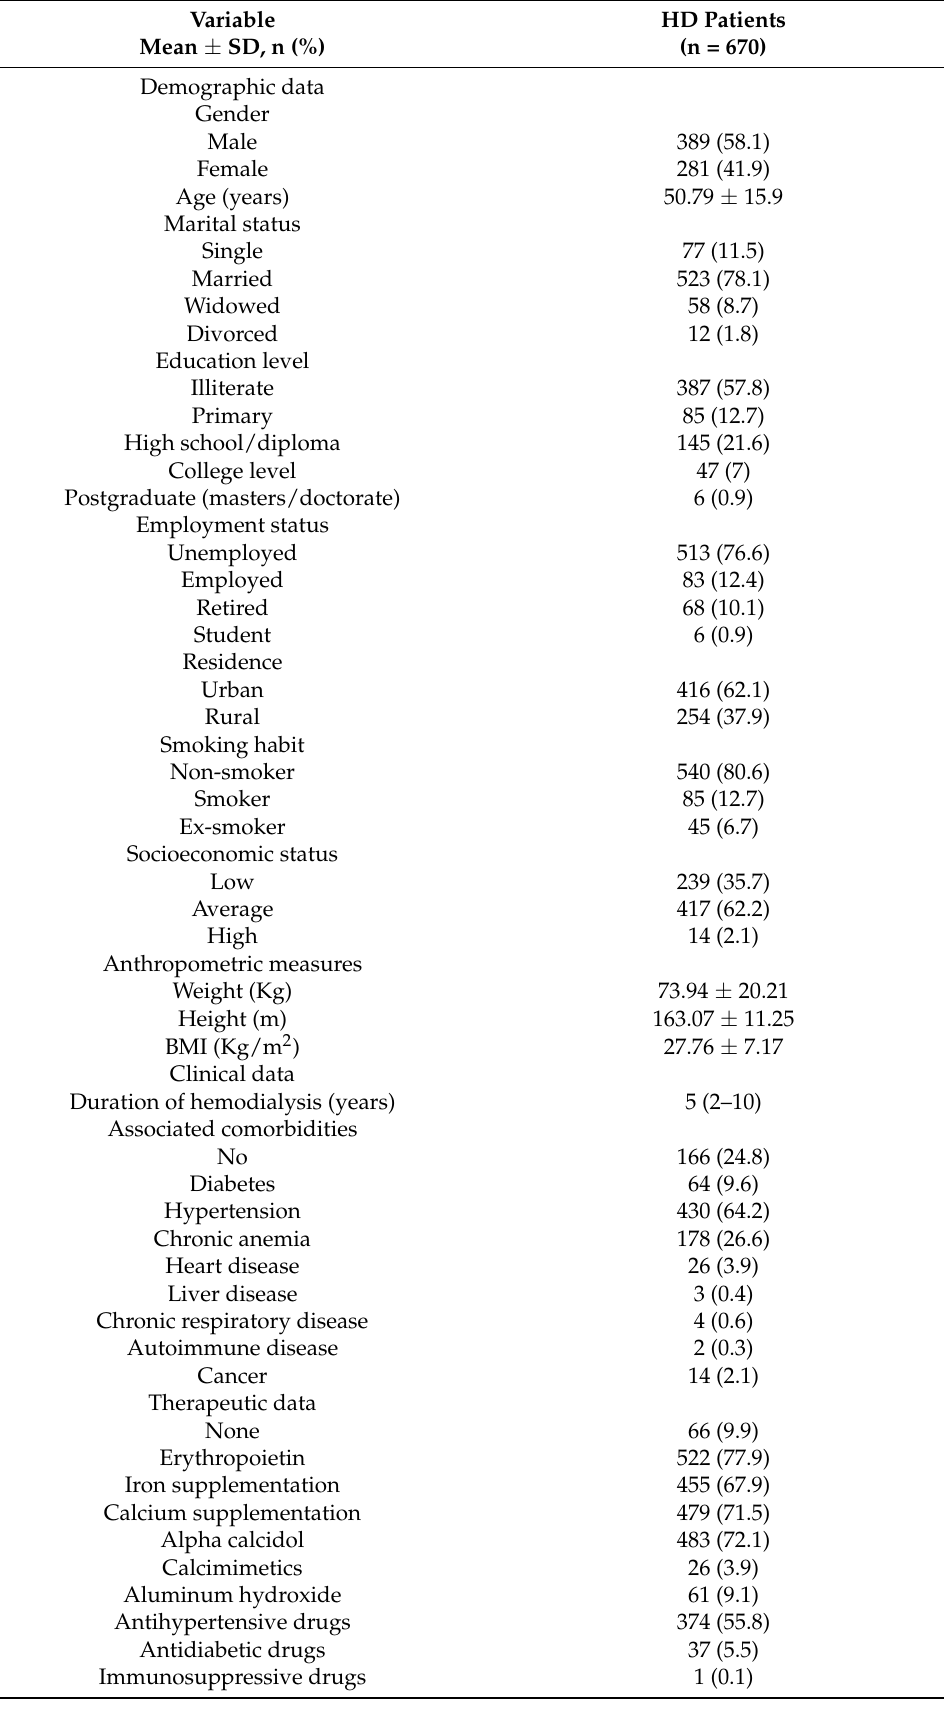
Table 1. Sociodemographic data and clinical characteristics of the studied CHD patients (n =